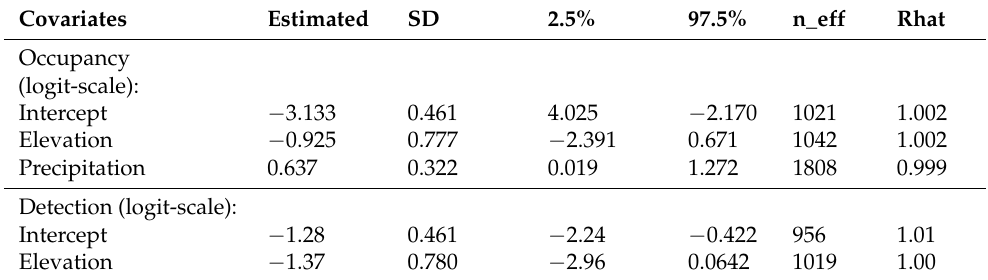
Table A3. Output summary from the best spatial occupancy model ( ψ (intercept + elevation + precipitation); ρ (intercept + elevation)) of white-winged parakeet ( Brotogeris versicolurus ) in Puerto Rico. Runtime: 13.692 min.